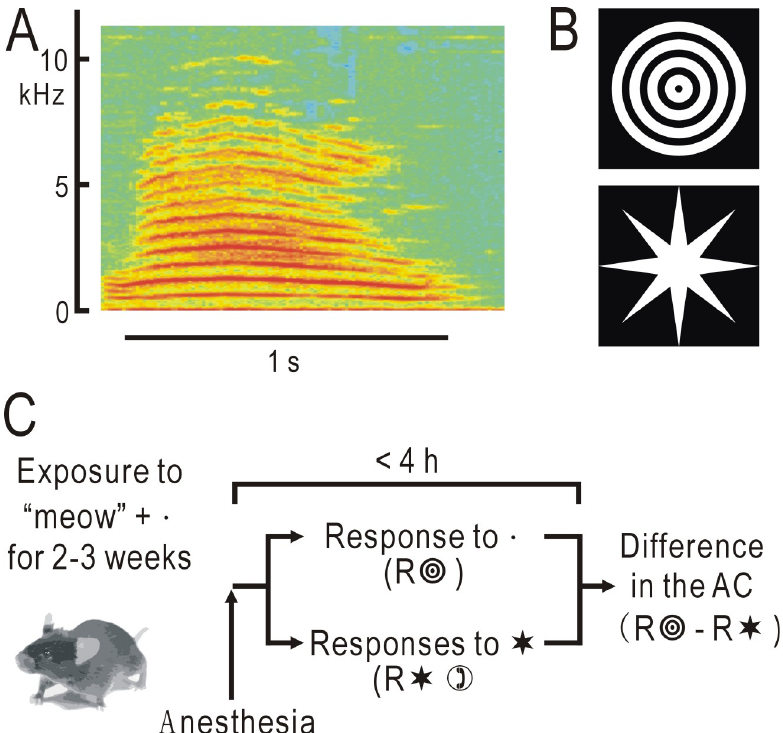
Fig 1. Methods for visualizing associative auditory responses. (A) Spectrogram of an artificial sound mimicking the sound of a cat’s “meow”. A part of this sound lasting 1 s (horizontal line) was used in the present study. (B) Visual shape stimuli of concentric circles with an angle of view of approximately 20˚, or stars. These images were used as test or control shape stimuli. (C) Experimental schedule. Mice were pre-exposed to the test visual shape stimulus synchronized with the “meow” sound, producing an audio-visual associative memory. After the exposure, mice were anesthetized and responses to the test visual stimulus and the other control shape stimulus were recorded in the AC. The difference between the responses was obtained in each mouse and averaged in a group of mice that received the same experimental procedure (n = 12–18 for each group).